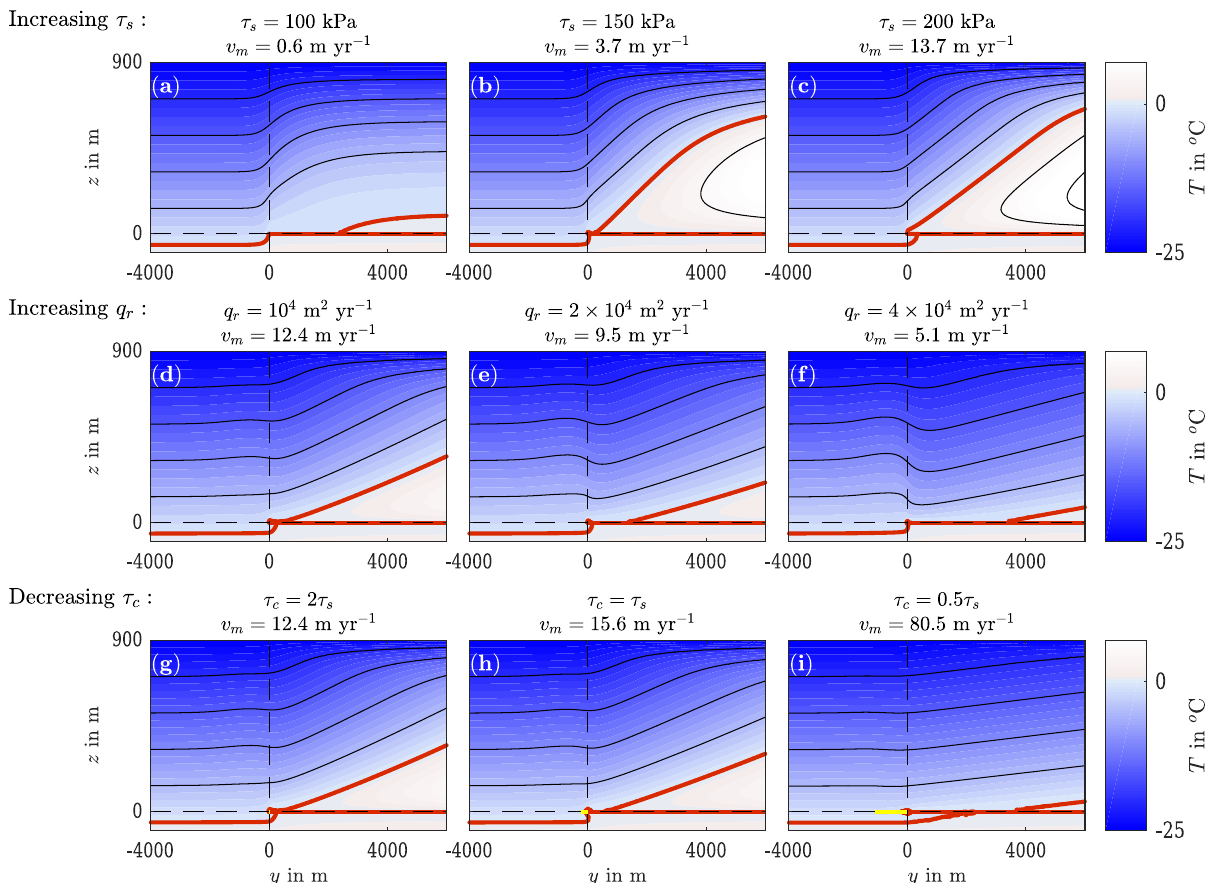
Figure 3. The effect of shear heating (represented by τ s ), advection (represented by q r ), and subtemperate basal sliding (represented by τ c ) on the temperature field in an ice stream margin; same plotting scheme as in Fig. 2. Solid black lines show contours in 5 ◦ C intervals with the contour of T =0 ◦ C in red. Thin dashed lines indicate the ice–bed interface and the location of the cold–temperate transition at the ice–bed interface. Red shading indicates the formation of temperate ice. Note that T should be interpreted as a proxy for moisture content when T > 0. In this case we can identify φ = ρc p T/(ρ w L) , with φ being the volumetric moisture content of the ice, ρ w the density of water, and L latent heat per unit mass. Panels (a – c) have q r = 0, τ c = ∞ (i.e., no subtemperate slip), and values of τ s as indicated above the panel. Panels (d – f) have τ s = 200kPa and τ c = ∞ . Panels (g – i) have τ s = 200kPa and q r = 10 4 m 2 yr − 1 . The yellow lines in panels (g – i) mark the extent of the subtemperate slip region. All other values as listed in Table